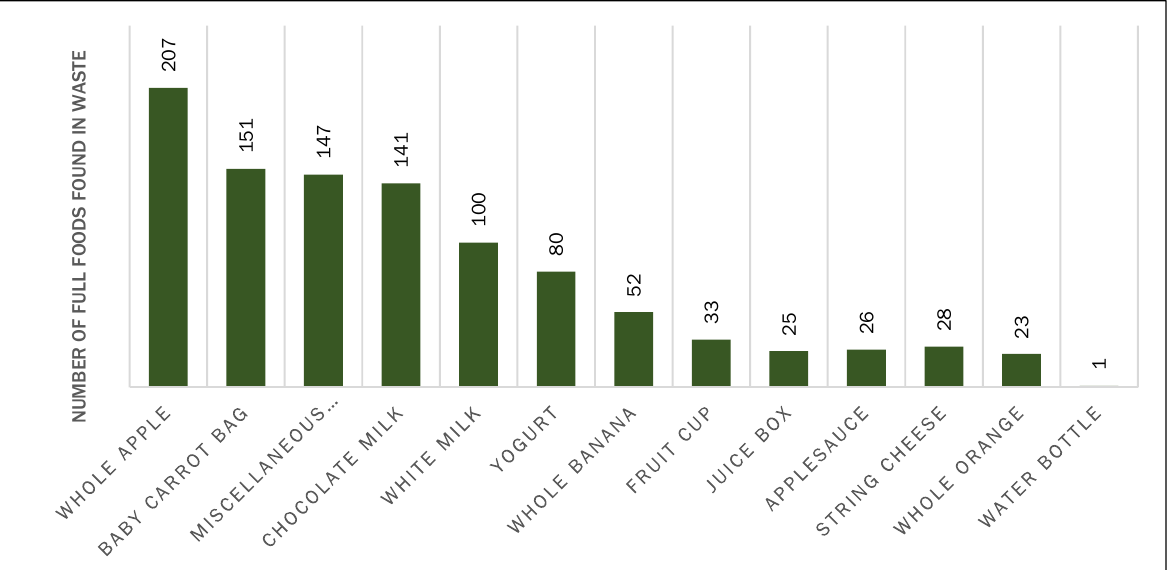
Figure 6. Rescuable Foods Found in Waste Bins at All Schools